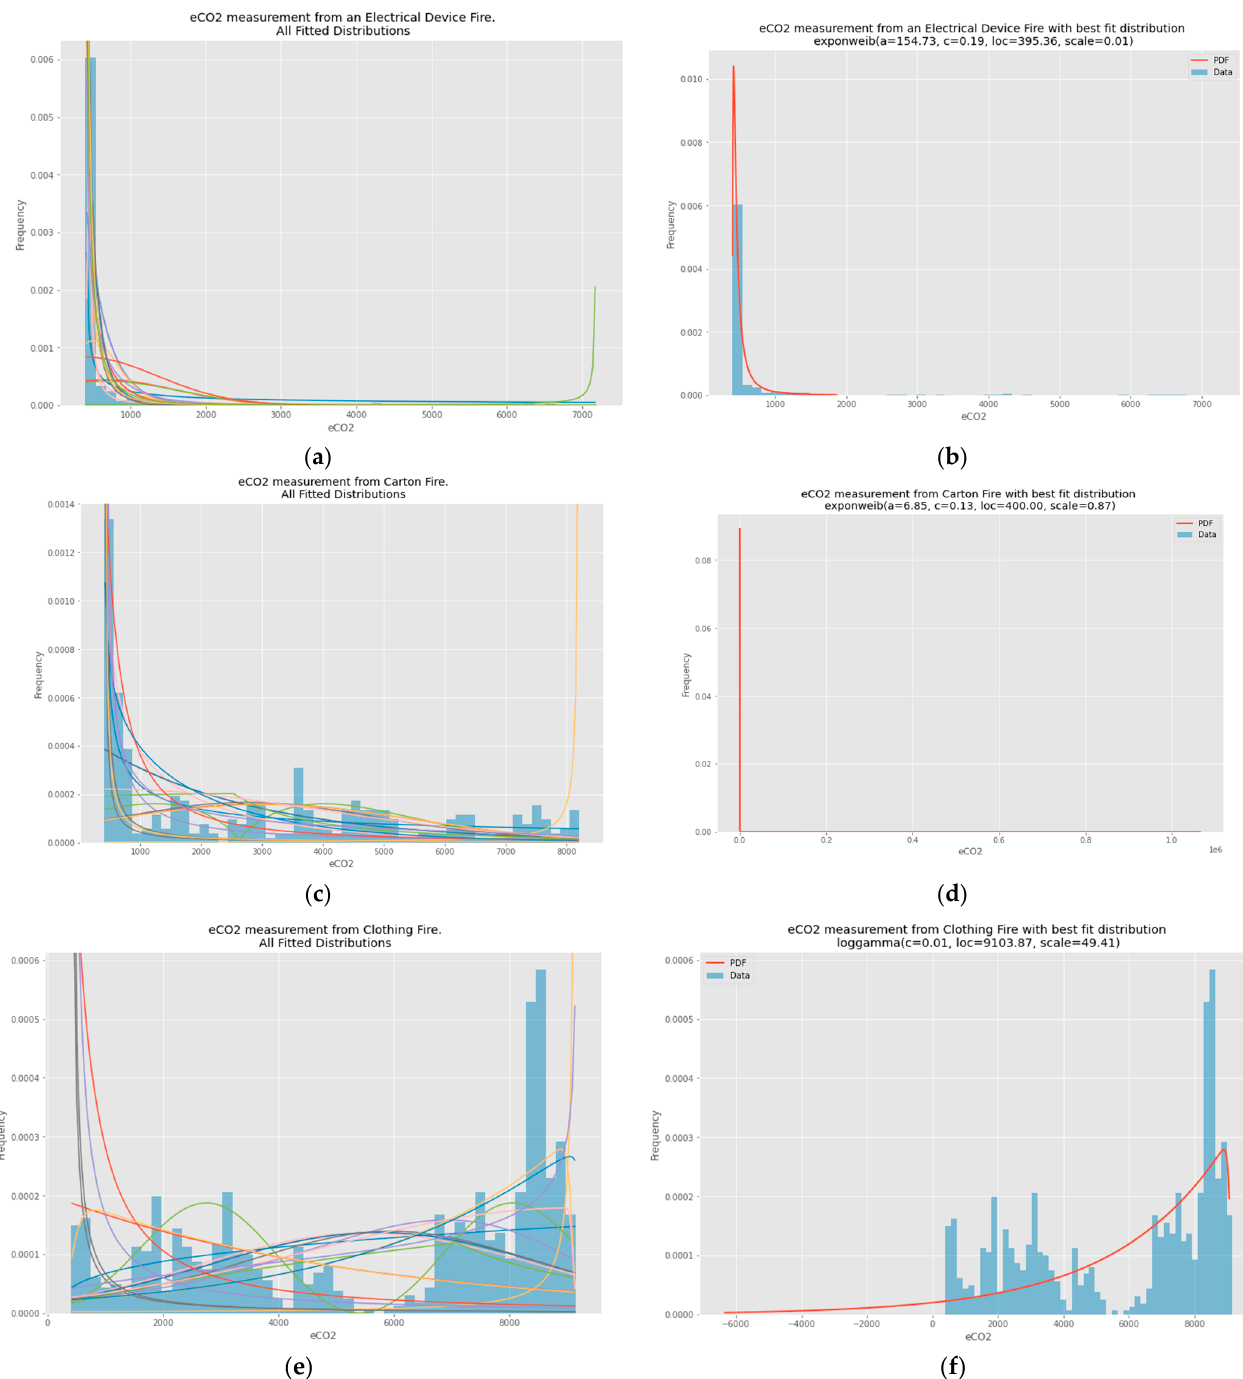
Figure 7. All the fitted distributions for the eCO 2 measurement for each fire source, namely, electri- cal device/clothing, charcoal/clothing, and charcoal/cardboard ( a – f